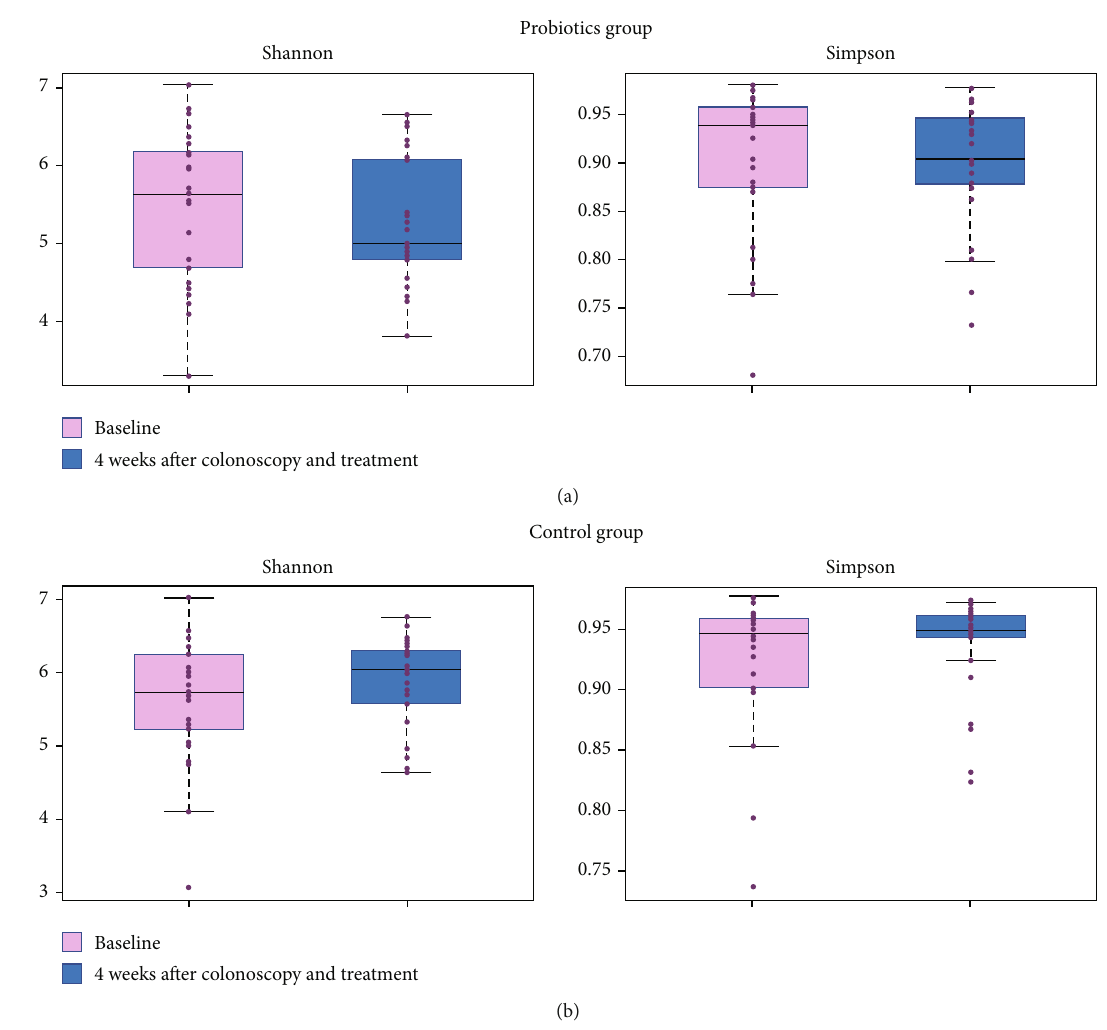
Figure 4: Box plot of the Shannon index and Simpson index in the probiotics group (a) and control group (b). Shannon index and Simpson index, indicating an α -diversity, were signi fi cantly lower in the 4 weeks after colonoscopy and treatment than those in the baseline of probiotics group. There was no signi fi cant di ff erence in the control